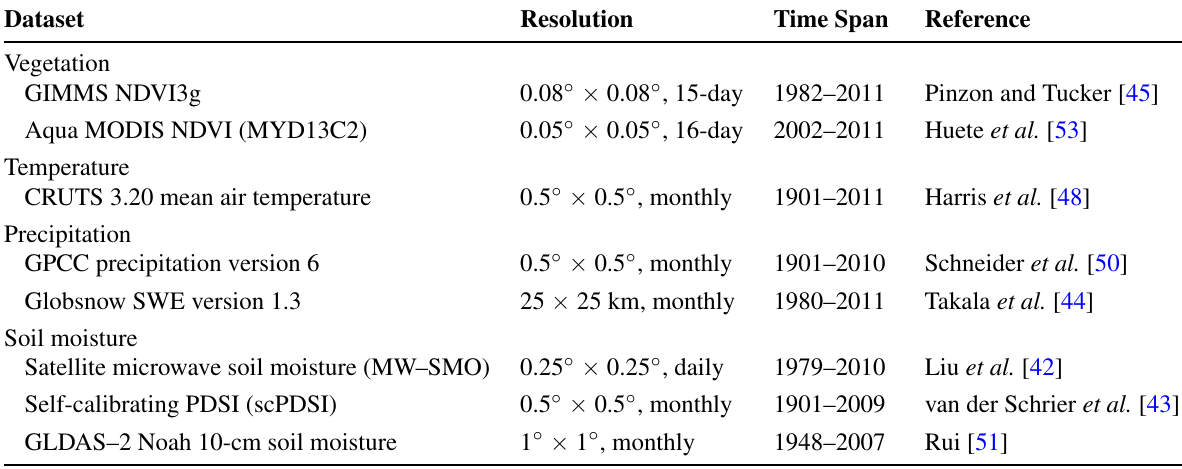
Table 1. Characteristics of the datasets used in this